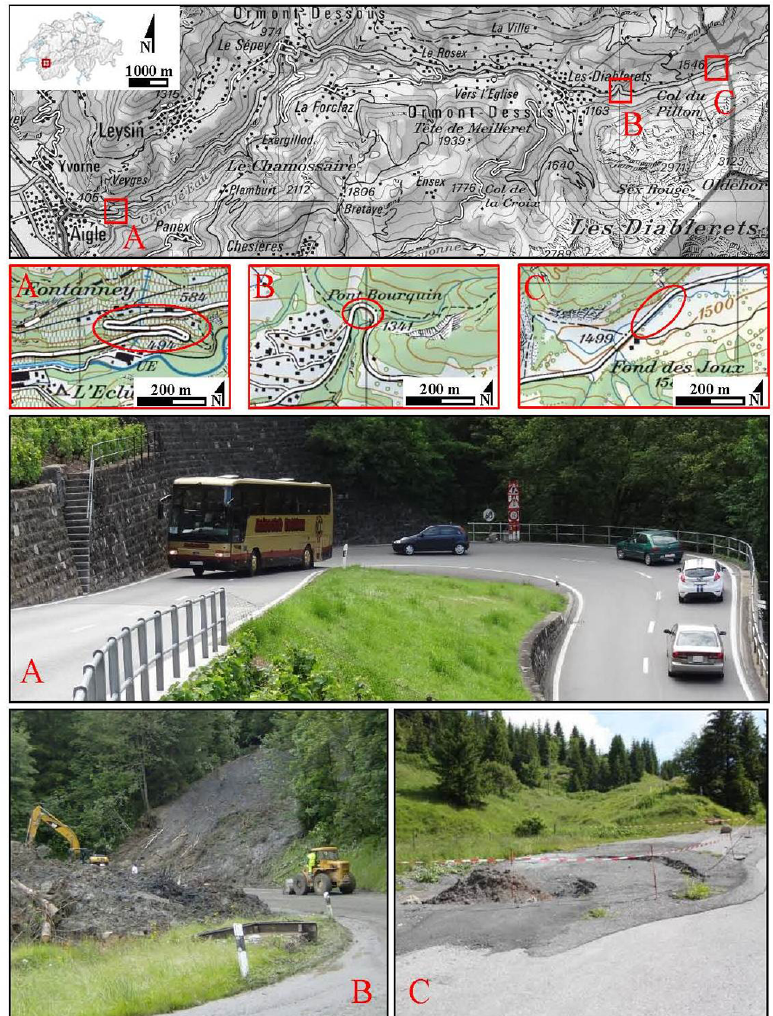
Fig. 4. Location of the three sections on the study road Aigle – Col du Pillon, in Vaud canton, Switzerland. (A) Fontanney section with debris flows hazard. The picture shows the south hairpin bend with road works traffic signs and different types of vehicles (2012). (B) Pont- Bourquin section threatened by an active landslide (picture of the 2007 event). (C) Col du Pillon section with doline hazard (picture of the 2009 event). (Copyright for topographical maps: Swisstopo). Table 2. Description of the three sections from the studied road Aigle – Col du Pillon, in Vaud canton, Switzerland. The results of